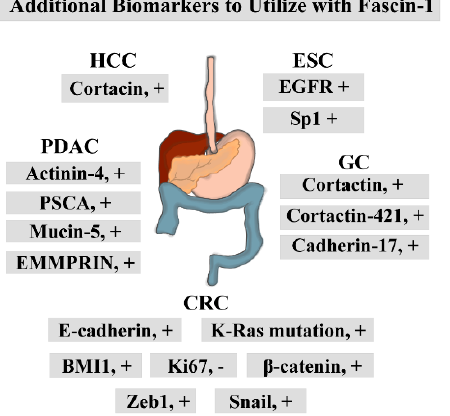
Figure 3. The biomarkers that can be utilized alongside fascin-1 IHC to improve the diagnostic po- tential of fascin-1. +, positive correlation; -, negative correlation. potential of fascin-1. +, positive correlation; -, negative